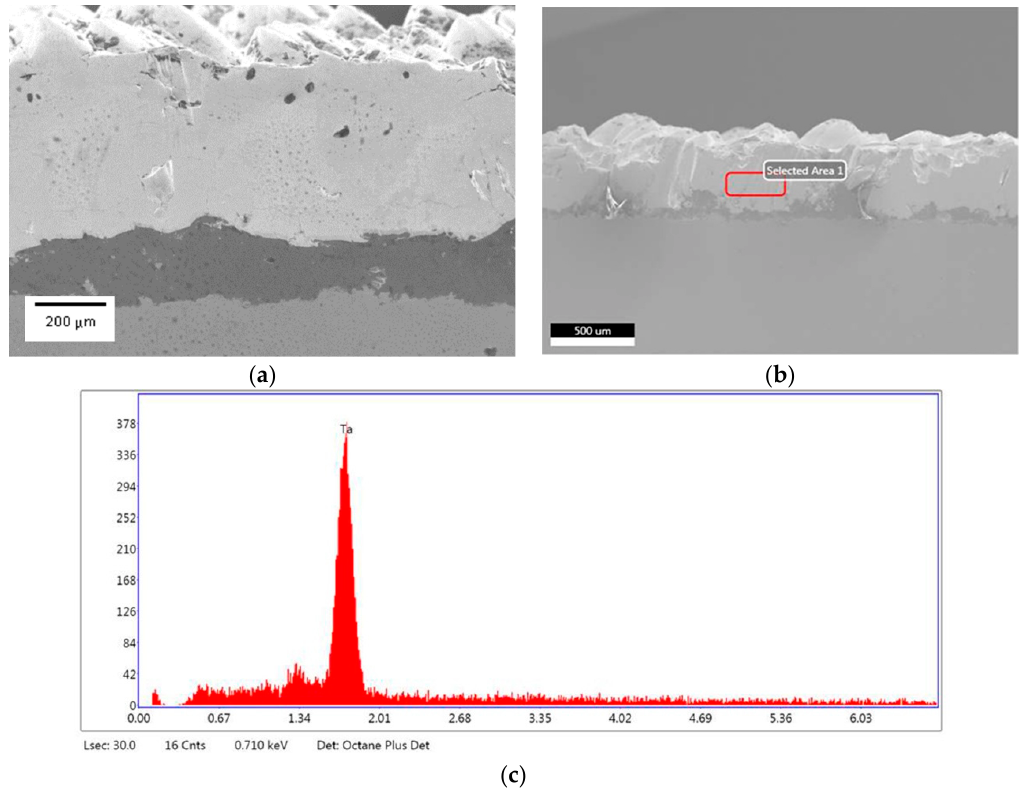
Figure 4. Ta (400 μ m)/Al (100 μ m)/SS test piece: Shows the cross-section characteristics of the Figure 4. Ta (400 µ m) / Al (100 µ m) / SS test piece: Shows the cross-section characteristics of the